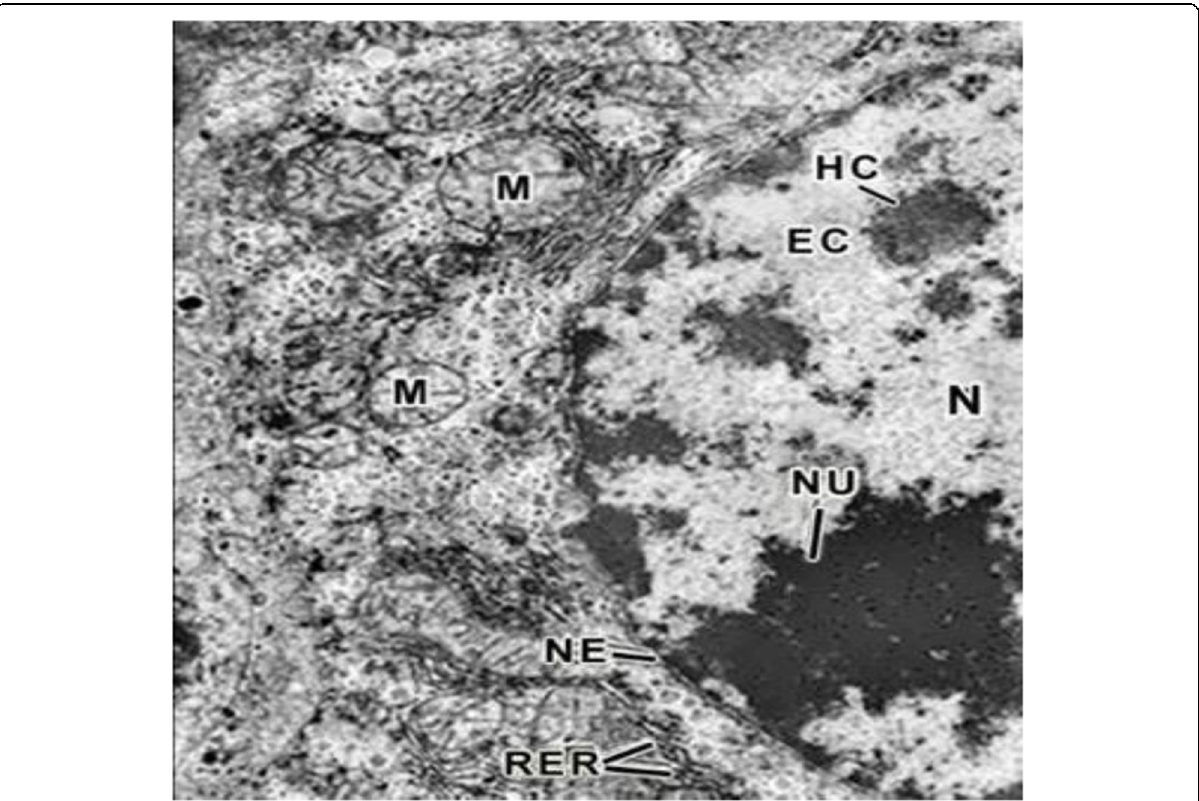
Fig. 12 An electron micrograph of a hepatocyte showing the rough endoplasmic reticulum (RER), many mitochondria (M), part of the nucleus (N) with distinct nuclear envelope (NE), well-defined nucleolus (NU), and nucleoplasm having loose euchromatin (EC) and compact heterochromatin (HC) in normal figuring. (×